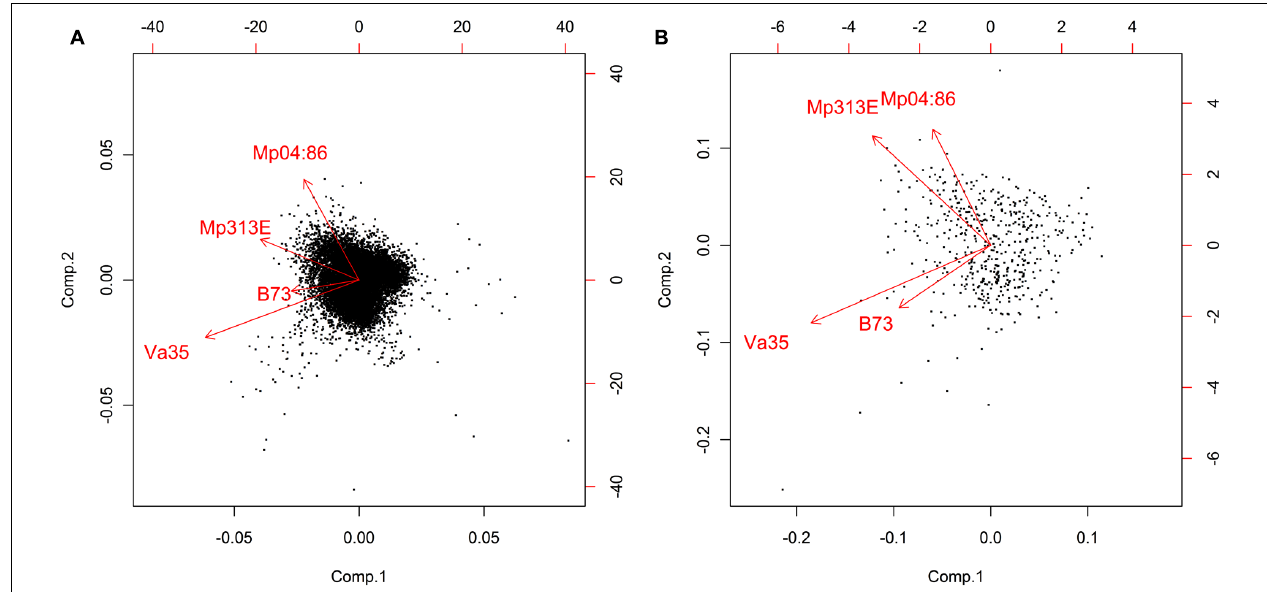
FIGURE 2 | Biplots of PCA on the log2 ratios ( I/U ) of expressed genes in corn inbred lines. The eigenvectors evidently separated into resistant and susceptible groups, respectively. Genes coordinately expressed in resistant lines located near the eigenvectors for Mp313E and Mp04:86. Genes